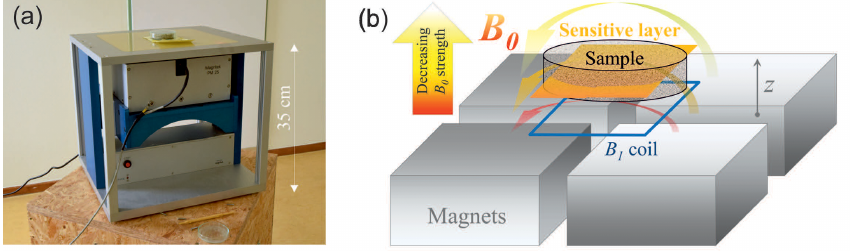
Figure 2. (a) Measurement device and (b) schematic showing the configuration of the permanent B 0 magnets, B 1 coil, and the resulting sensitive